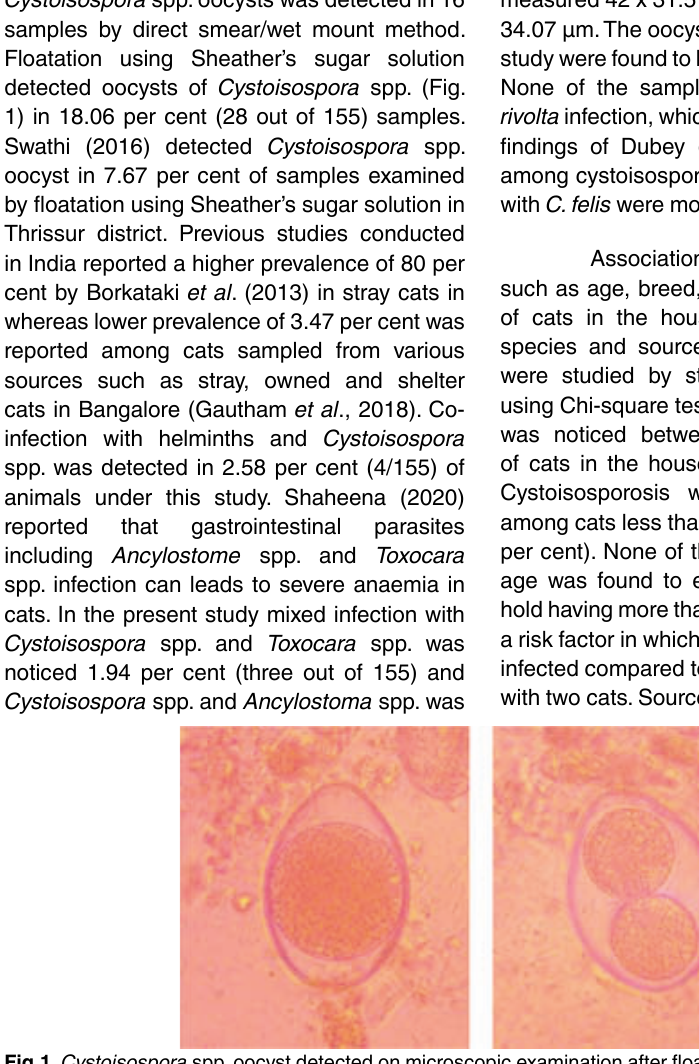
Fig.1. Cystoisospora spp. oocyst detected on microscopic examination after